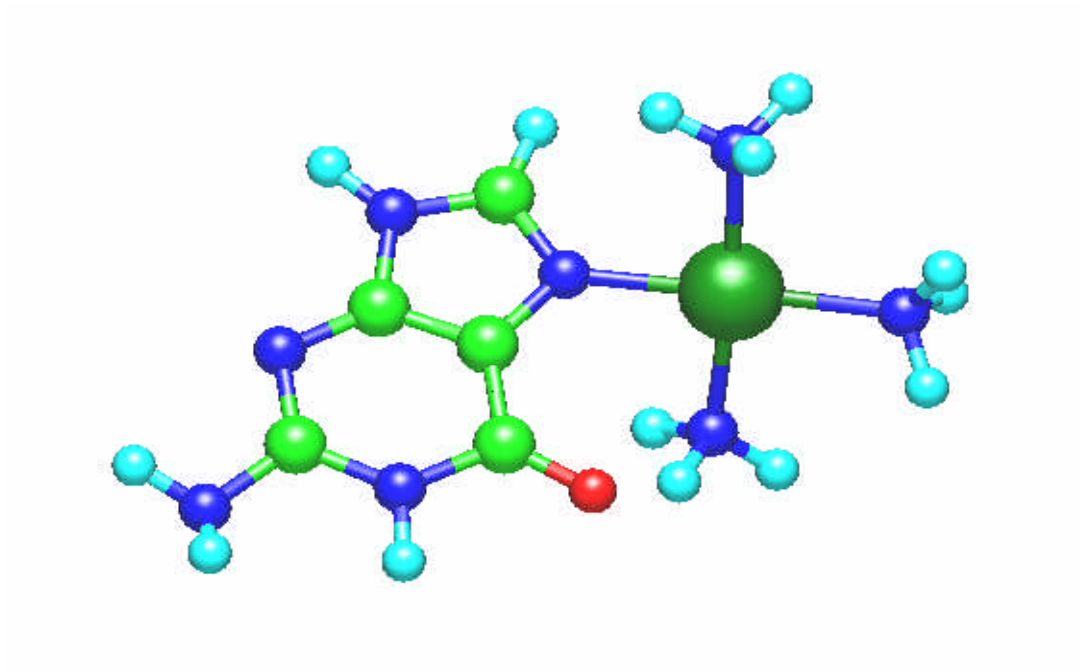
Fig. 3. The unusual resulting molecular structure of the [Sn(CH group is bonded to the oxygen O6 atom and [Sn(CH plane.